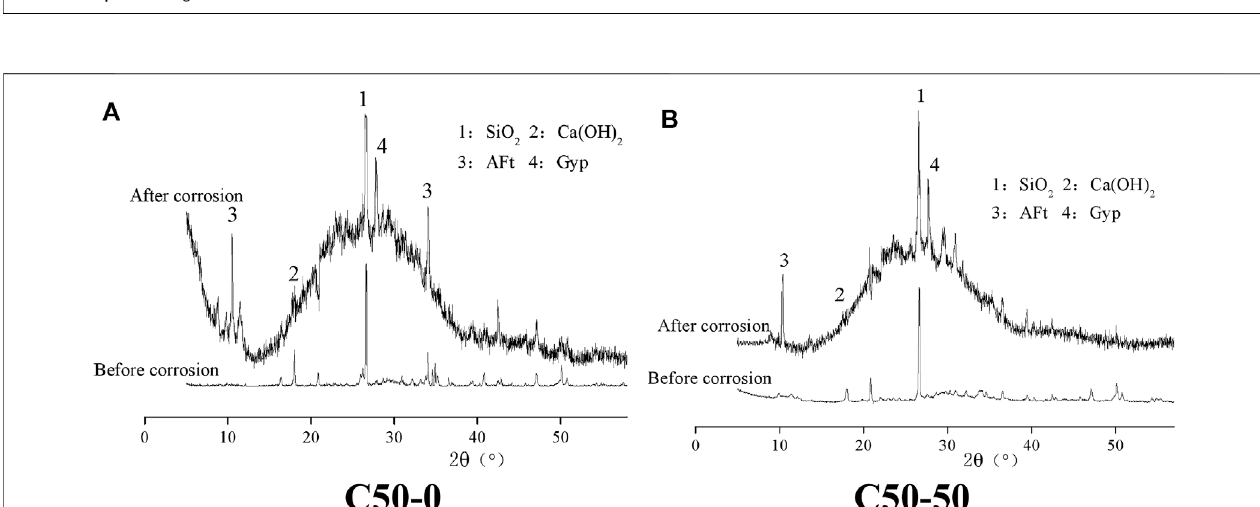
FIGURE 5 | SEM images of C50-50 concrete before and after sulfate corrosion.